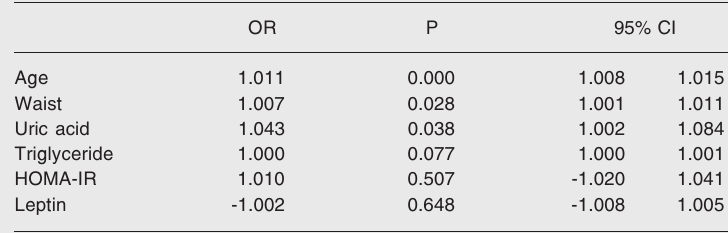
Adjusted for 2-h glucose, C-reactive protein and non-HDL cholesterol (nonsignificant). HOMA-IR = homeostasis model assessment of insulin resistance; OR = odds ratio; 95% CI = 95% confidence